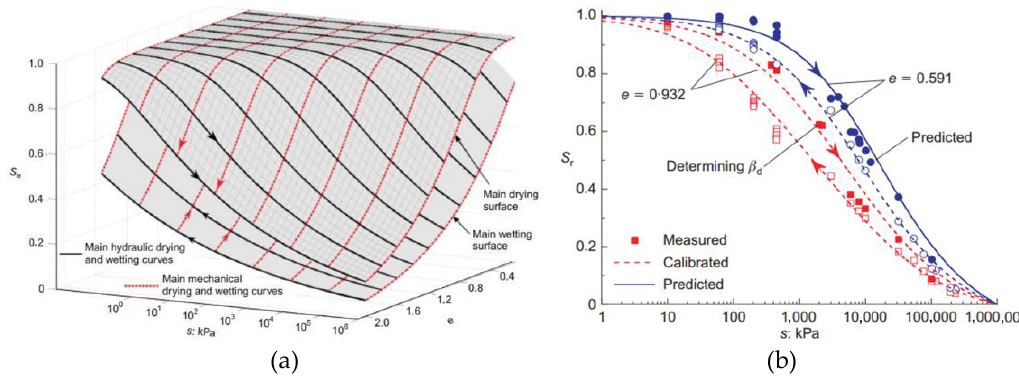
Figure 10. Water-holding characteristics curve of deformable soil/rockmass [62]: ( a ) Dominant moisture ab-/de-sorption contours; ( b ) Unsaturated characteristic curves containing dry/humid cycling effect on seepage and deformation.